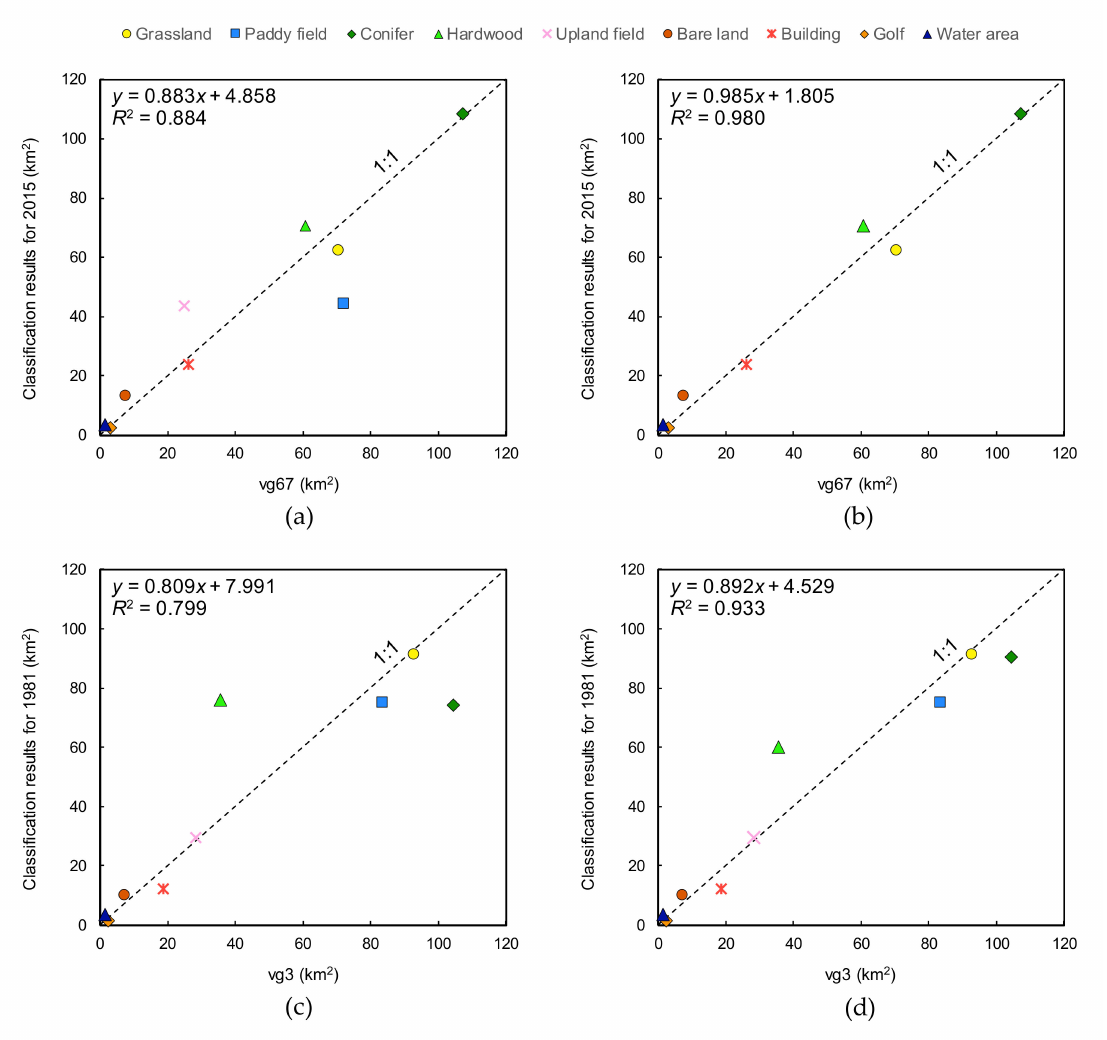
Figure 4. Relationships between vegetation maps and classification analysis results: ( a ) 2015 against vegetation map; ( b ) 2015 against vegetation map, except for paddy and upland fields; ( c ) 1981 against vegetation map; ( d ) modified 1981 against vegetation